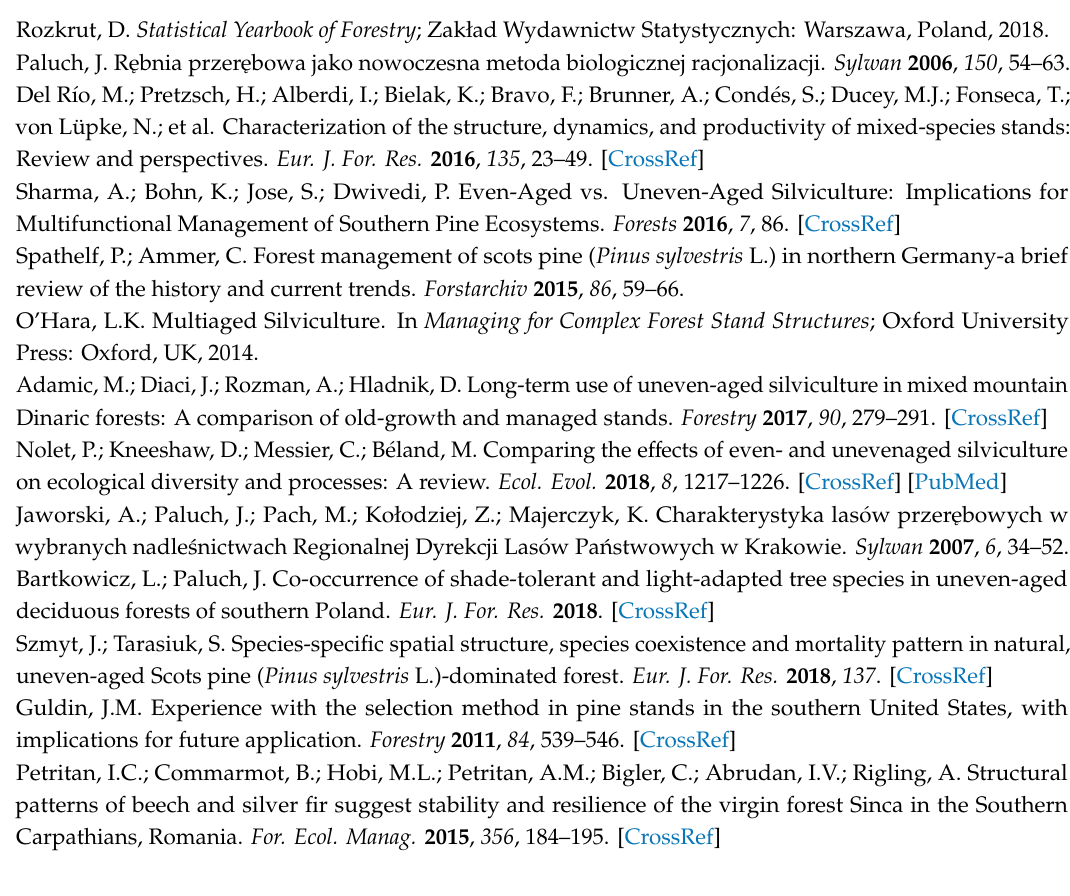
Figure S1: Species-specific diameter distribution over the observed period (specified years) in the multispecies uneven-aged forest located in the Uniesz ó w Forestry Range. Figure S2: Variation of Shannon species diversity index (SSP) on measurement plots in 1993, 2006 and 2017 inventories (from top to the bottom) in the multispecies uneven-aged forest located in the Uniesz ó w Forestry Range. Figure S3: Variation of Gini size inequality index (GI) on measurement plots in 1993, 2006 and 2017 inventories (from top to the bottom) in the multispecies uneven-aged forest located in the Uniesz ó w Forestry Range. Figure S4: Mean spatial positioning (CE), spatial mingling (DM) and spatial di ff erentiation of tree diameter (TD)—tree species pooled—at the neighborhood spatial scale over the investigated period. Figure S5: Mean values of CE, DM and TD indices and standard errors of the means calculated for tree species in 1993 ( a ), 2006 ( b ), and 2017 ( c ). Figure S6: Growth dominance curves for conifers present in the multispecies uneven-aged forest in two analyzed periods. Figure S7: Growth dominance curves for broadleaved tree species present in the multispecies uneven-aged forest in two analyzed periods; Table S1: Spatially inexplicit and spatially explicit indices describing the structural aspects of the forest. Table S2: Species-specific GI index ( ± standard deviation) describing the inequality in trees diameter over the 24-year